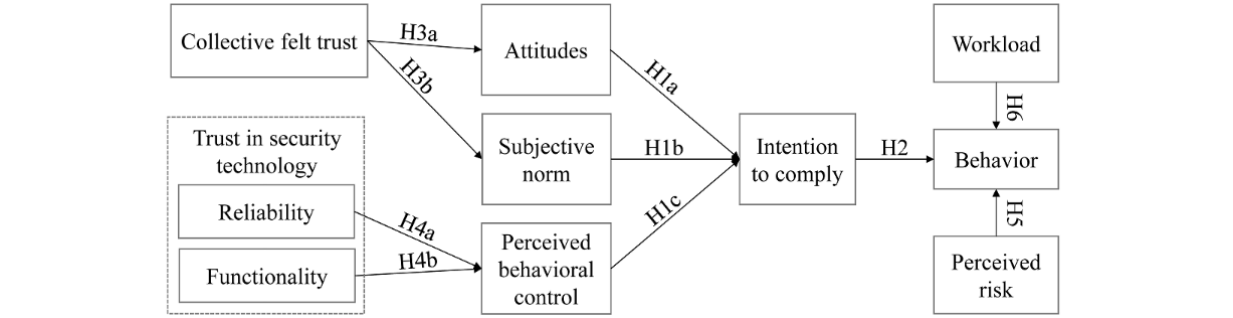
Figure 1. Proposed research model. H: